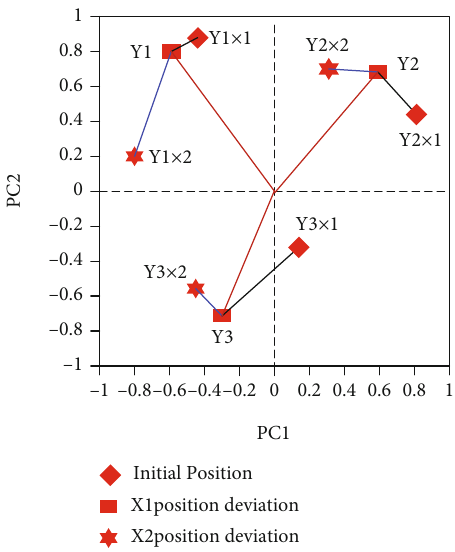
Figure 9: Relative position changes of the column pro fi le coordinate F generated as the numerical values of the key in fl uencing factors